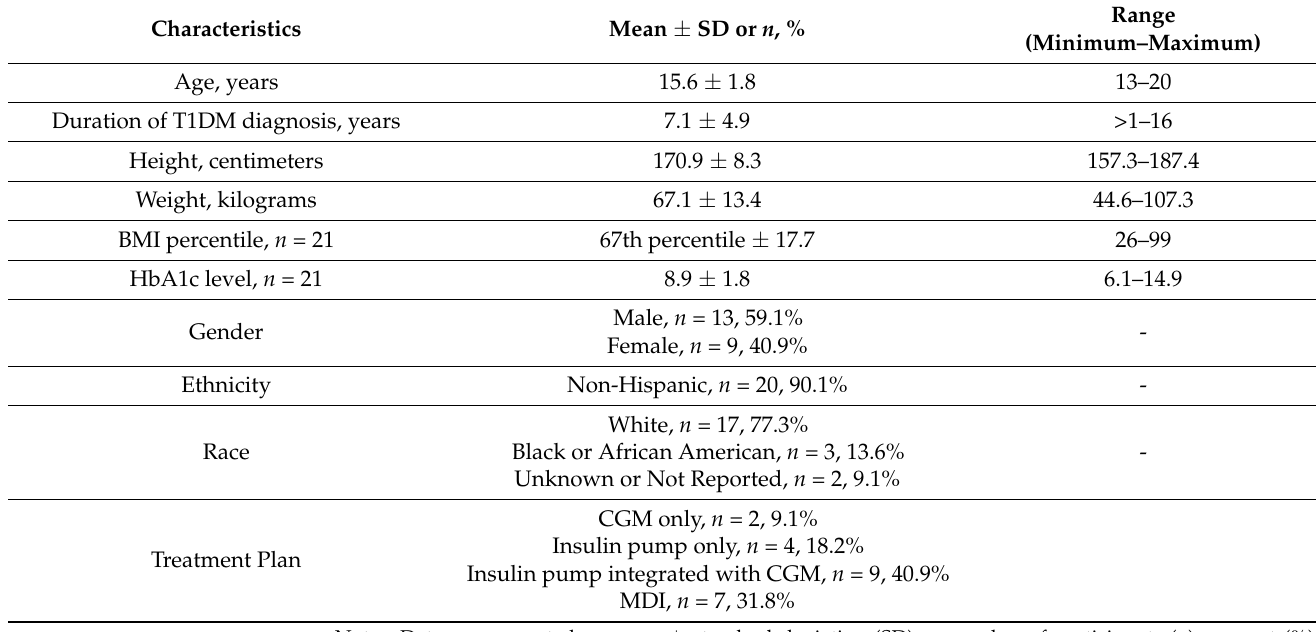
Table 1. Characteristics of the Participants, N =